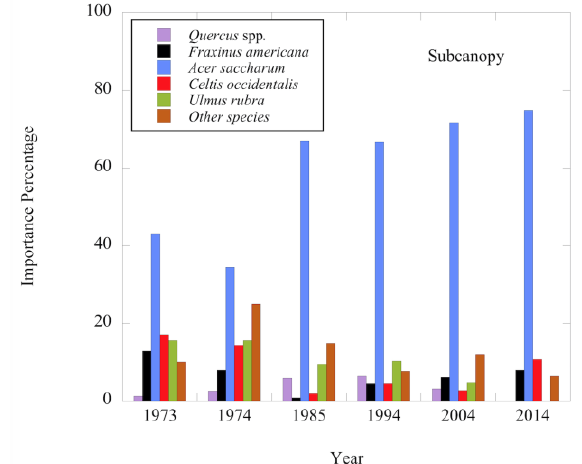
Figure 8. Density (N/ha) distribution by diameter class (DBH ≥ 10.0 cm) of Ulmus rubra individuals recorded at each of the six sampling periods at Dinsmore Woods.